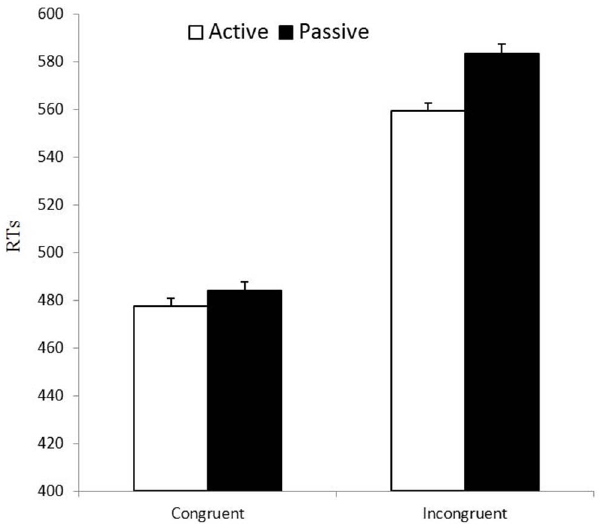
Figure 4. Conflict. Mean RT in the congruent and incongruent conditions associated to the executive network, for active and passive participants. The error bars represent one standard error of the mean.